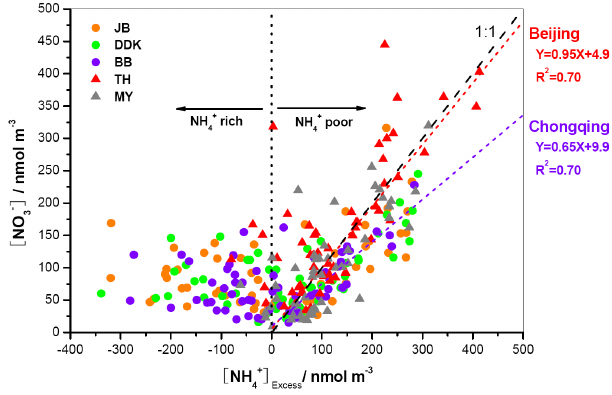
Fig. 9. Relationships between molar concentrations of [NO − [NH + ] Excess in PM 2 . 5 at Beijing (TH and MY) and Chongqing (JB, 4 DDK and